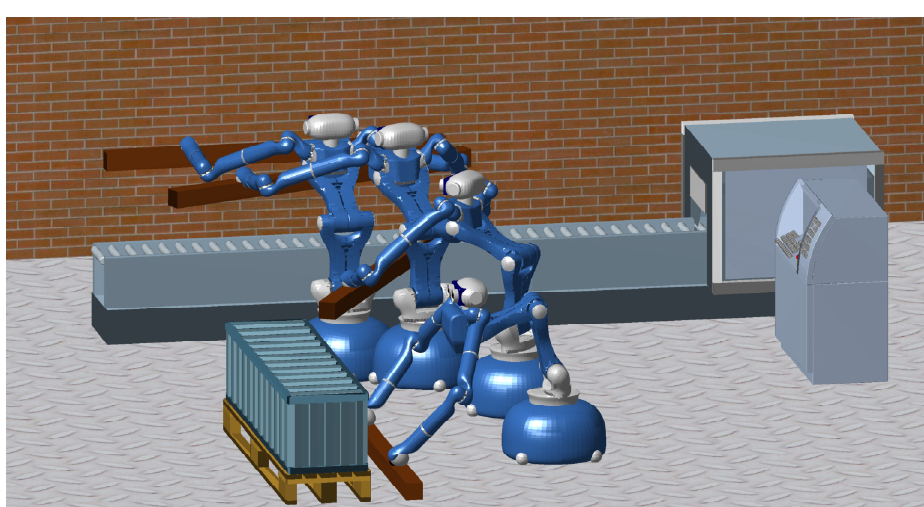
Figure 7. The second phase of the task: transporting the object.